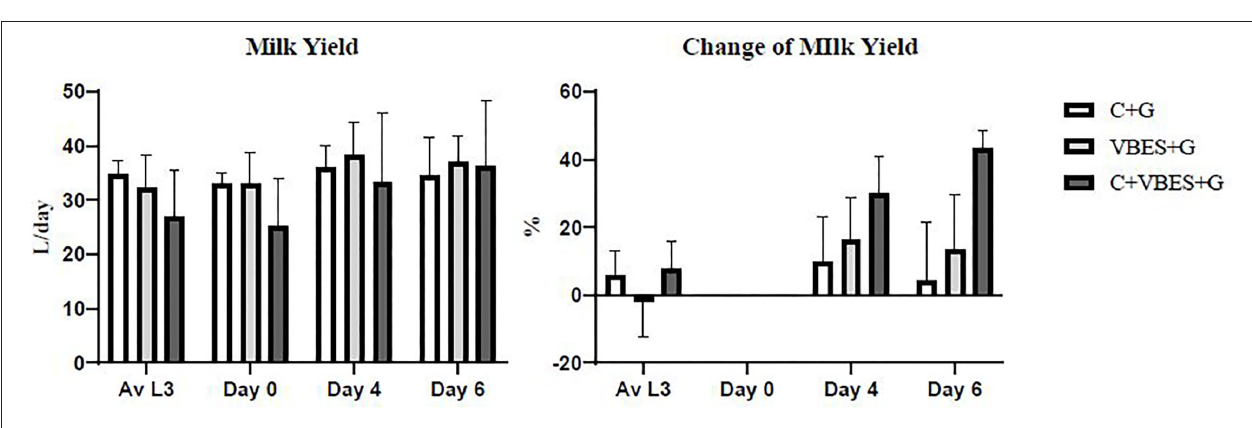
FIGURE 3 | Daily milk yield and change in daily milk yield compared with the onset day of ketosis. The value of Av L3 indicates the average of daily milk yields for the last 3 days before the onset day of ketosis. The values on days 0, 4, and 6 indicates daily milk yields on the pre-treatment day, 1 day after the last treatment day, and 3 days after the last treatment day, respectively. C + G = levocarnitine and glycerin, VBES + G = vitamin B complex, vitamin E with selenium, and glycerin, C + VBES + G = levocarnitine, vitamin B complex, vitamin E with selenium, and glycerin. Data are presented as the mean ± standard